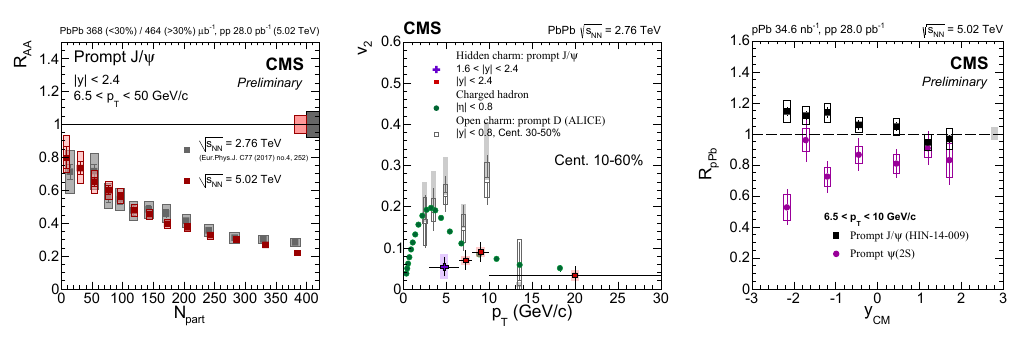
Figure 1. Left: R AA of prompt J /ψ mesons as a function of the number of participants to the collision, at √ s NN = 2 . 76 [2] and 5.02TeV [3]. Center: v 2 of prompt J /ψ mesons as a function of p T , at √ s NN = 2 . 76TeV, compared to that of other hadrons. Right: R pPb of prompt ψ (2 S ) [4] and prompt J /ψ [5] mesons at √ s NN = 5 . 02TeV, as a function of rapidity in the centre-of-mass